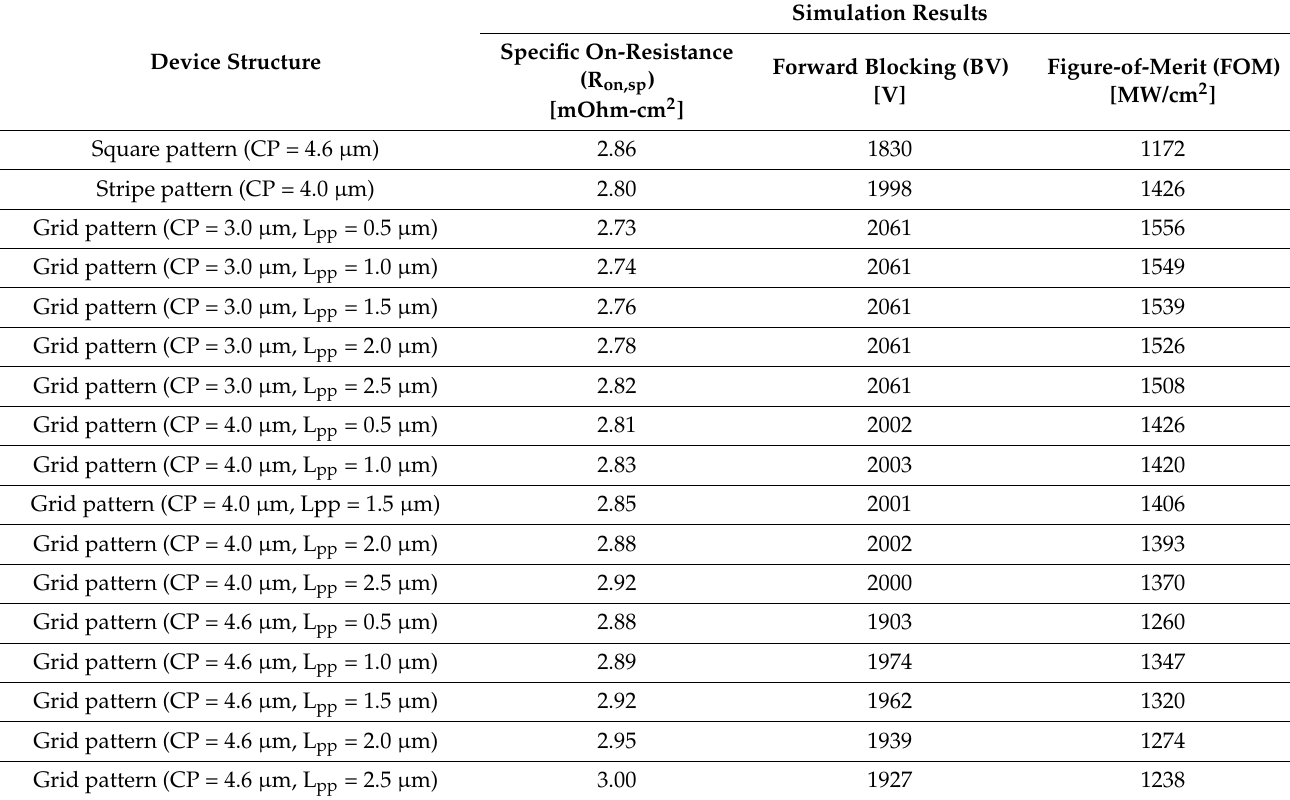
Table 2. Summary of device structures and static characteristics.